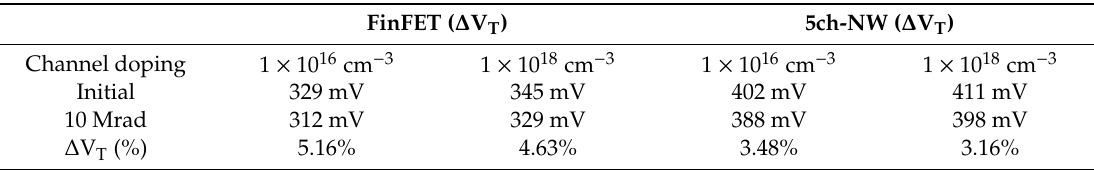
Table 4. V T variation according to the channel doping.